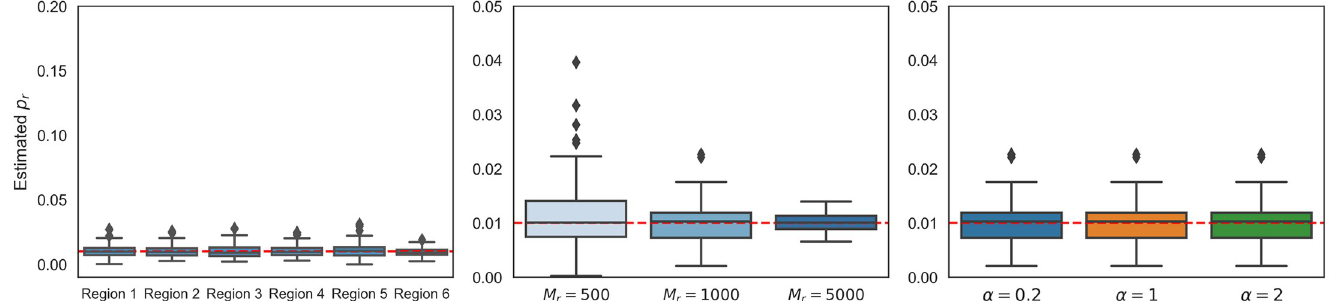
Fig 3. BEAVR is robust in realistic settings. (A) Using SNP data from chromosome 22 ( M = 9, 564 array SNPs, N = 337K individuals), we simulated 100 replicates where the genome-wide heritability was h 2 ¼ 0 : 50 and p = 0.01. We divided the data into 6-Mb consecutive regions for a total of 6 regions and estimated the regional GW heritability using external software (HESS [12]). Using BEAVR and the estimated regional heritability, we estimated the regional polygenicity to be unbiased across all regions. (B) We ran 100 replicates where the genome-wide heritability is fixed h 2 ¼ 0 : 50 , polygenicity p r = 0.01, sample size N = 500K, and then varied the number of GW SNPs in the region from M = 500, 1K, 5K SNPs. We used BEAVR to estimate the polygenicity in each region and found our results to be unbiased across all regions. (C) We set the genome-wide heritability to h 2 ¼ 0 : 50 , regional polygenicity p r = 0.01, and sample size N = 500K. We find that the accuracy of our results is invariant GW to our choice of prior hyper-parameter ( α ).